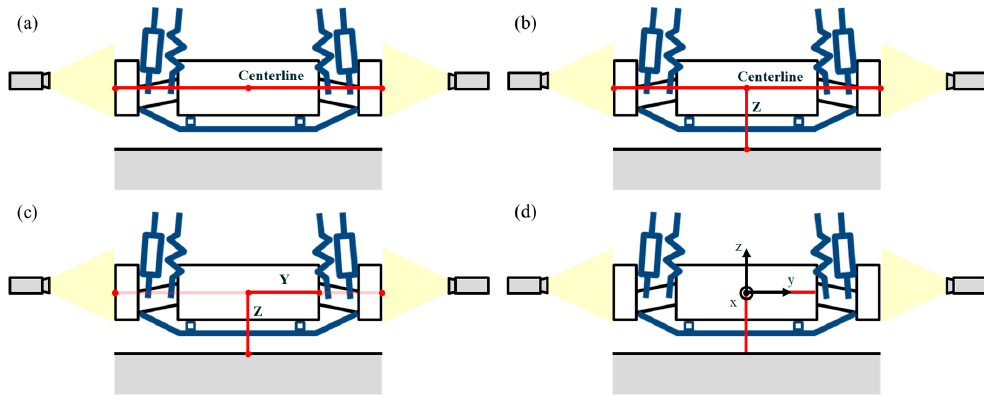
Figure 14. Absolute coordinate creation. ( a ) Centerline. ( b ) Z axis. ( c ) Y axis. ( d ) X axis.